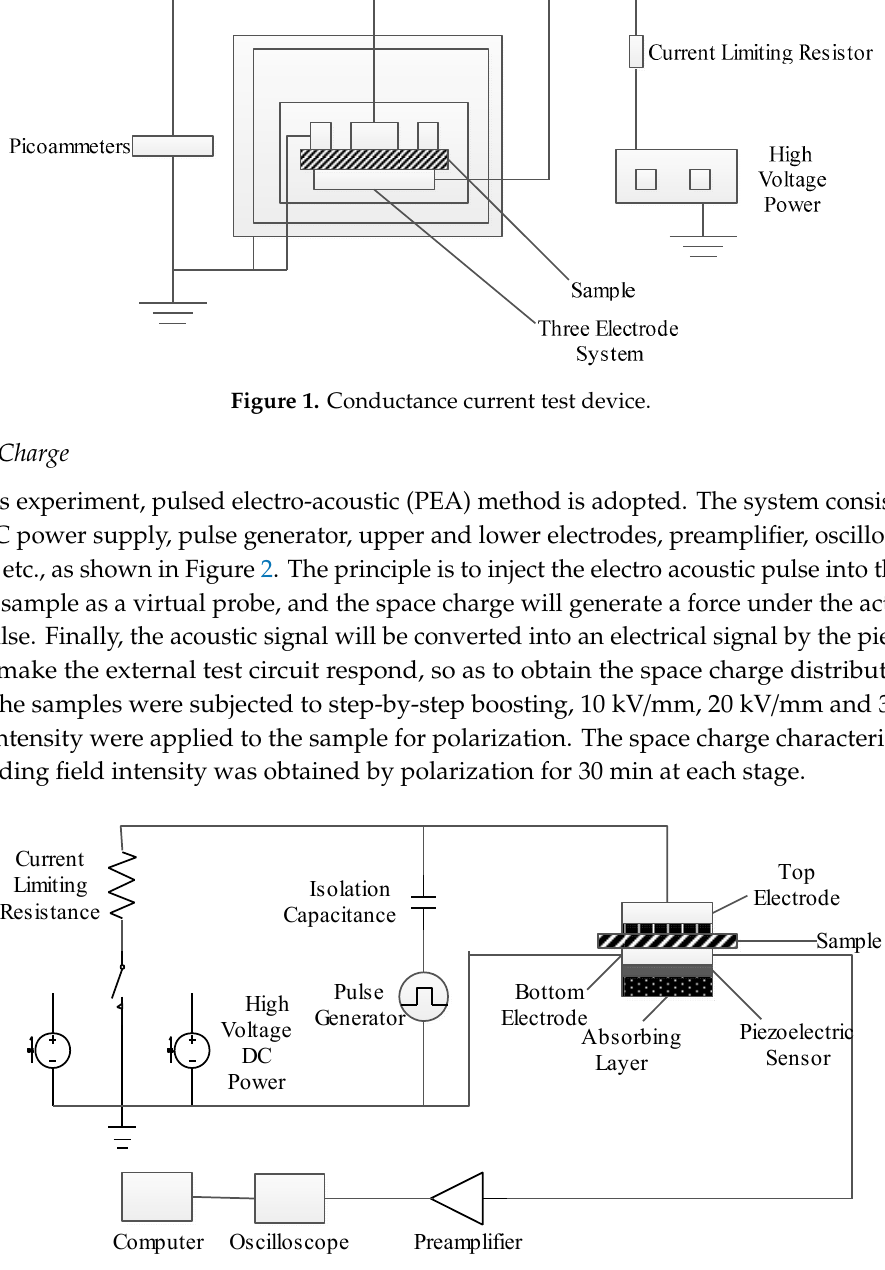
Figure 2. Experimental system of pulsed electro-acoustic method.